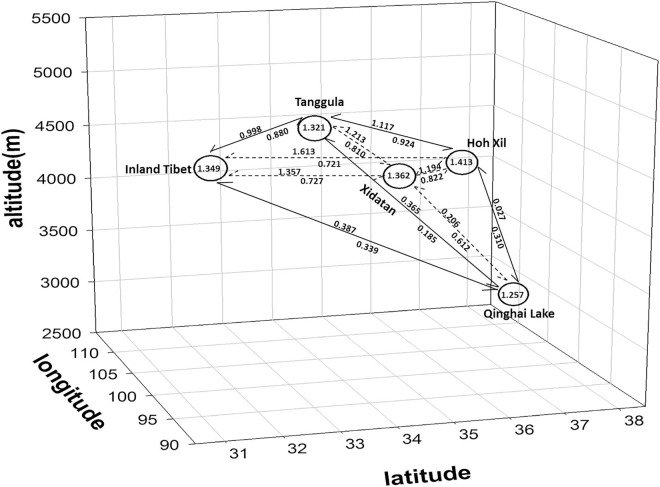
Number of migrants per generation (M) between genetically divergent regions.Nm was calculated by a Bayesian method implemented in MIGRATE. Numbers in circles indicate Nm between populations within a region; numbers above or below the lines are Nm between regions; arrows show the direction of gene flow. The regions shown are Inland Tibet (IT), Tanggula Mountains (TM), Xidatan (XD), Hoh Xil (HX), and Qinghai Lake (QL) based on the results of STRUCTURE when K = 2 (Fig 3).